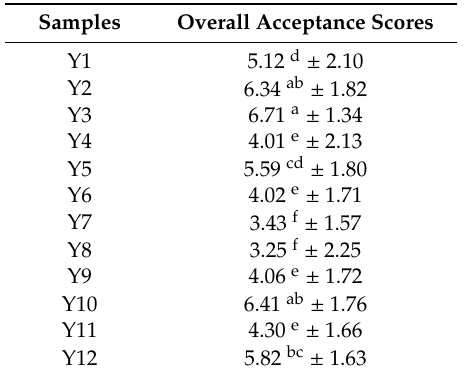
Table 4. Mean scores for the consumers’ acceptance of the yakju samples 1,2